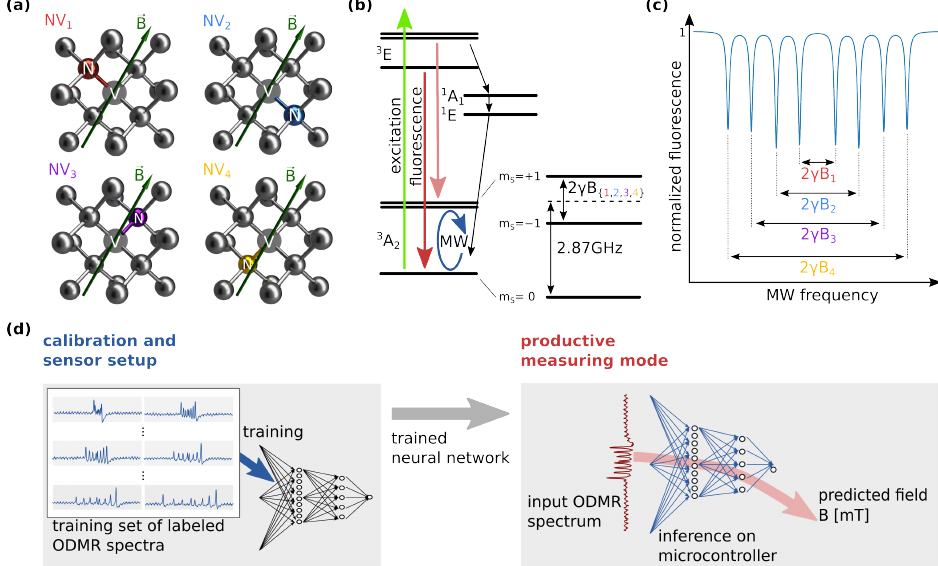
Figure 1. ( a ) Four orientations of the NV center in the diamond crystal structure. ( b ) Simplified energy level system of the NV center electron spin. Decay from the triplet excited state 3 E into the ground state 3 A 2 leads to a fluorescence in the visible spectrum with a zero-phonon line at 637 nm [14]. Decay from the m S = ± 1 excited state increases the probability of a transition via a singlet state with fluorescence in the non-visible spectrum. ( c ) Schematic ODMR spectrum showing the fluorescence intensity as a function of MW frequency as indicated in ( b ). Different